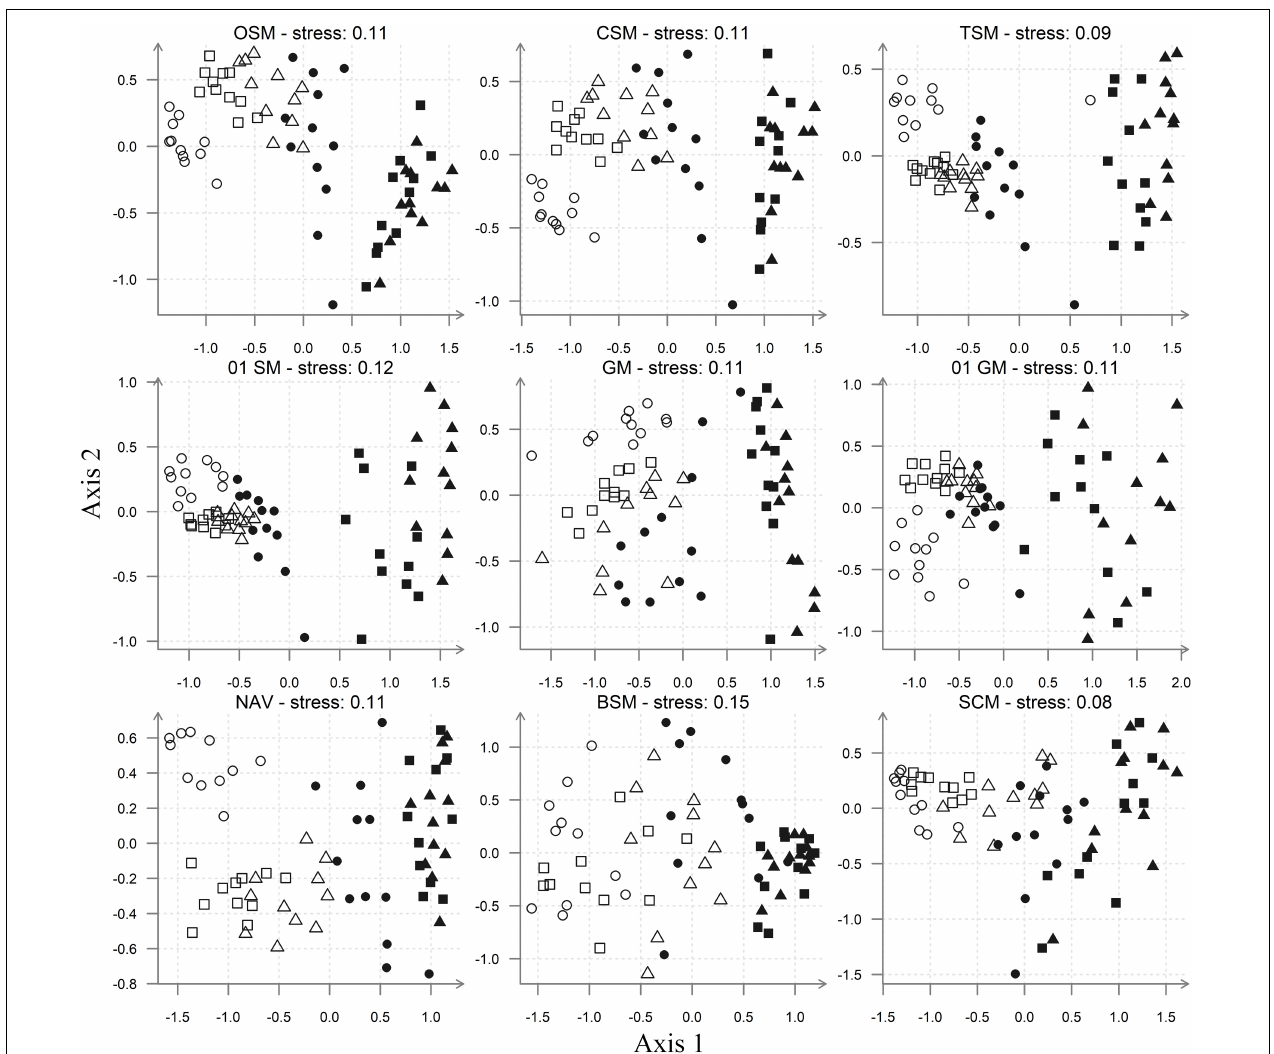
FIGURE 3 | MDS ordinations, based on Bray–Curtis similarity. Resemblance matrices included: Species (OSM, CSM, TSM, and Navicula ) and genera (GM) abundances datasets; species relative biovolume dataset (BSM); species (0–1 SM) and genera presence–absence datasets (0–1 GM); size-class abundances datasets (SCM). Sampling stations: A1